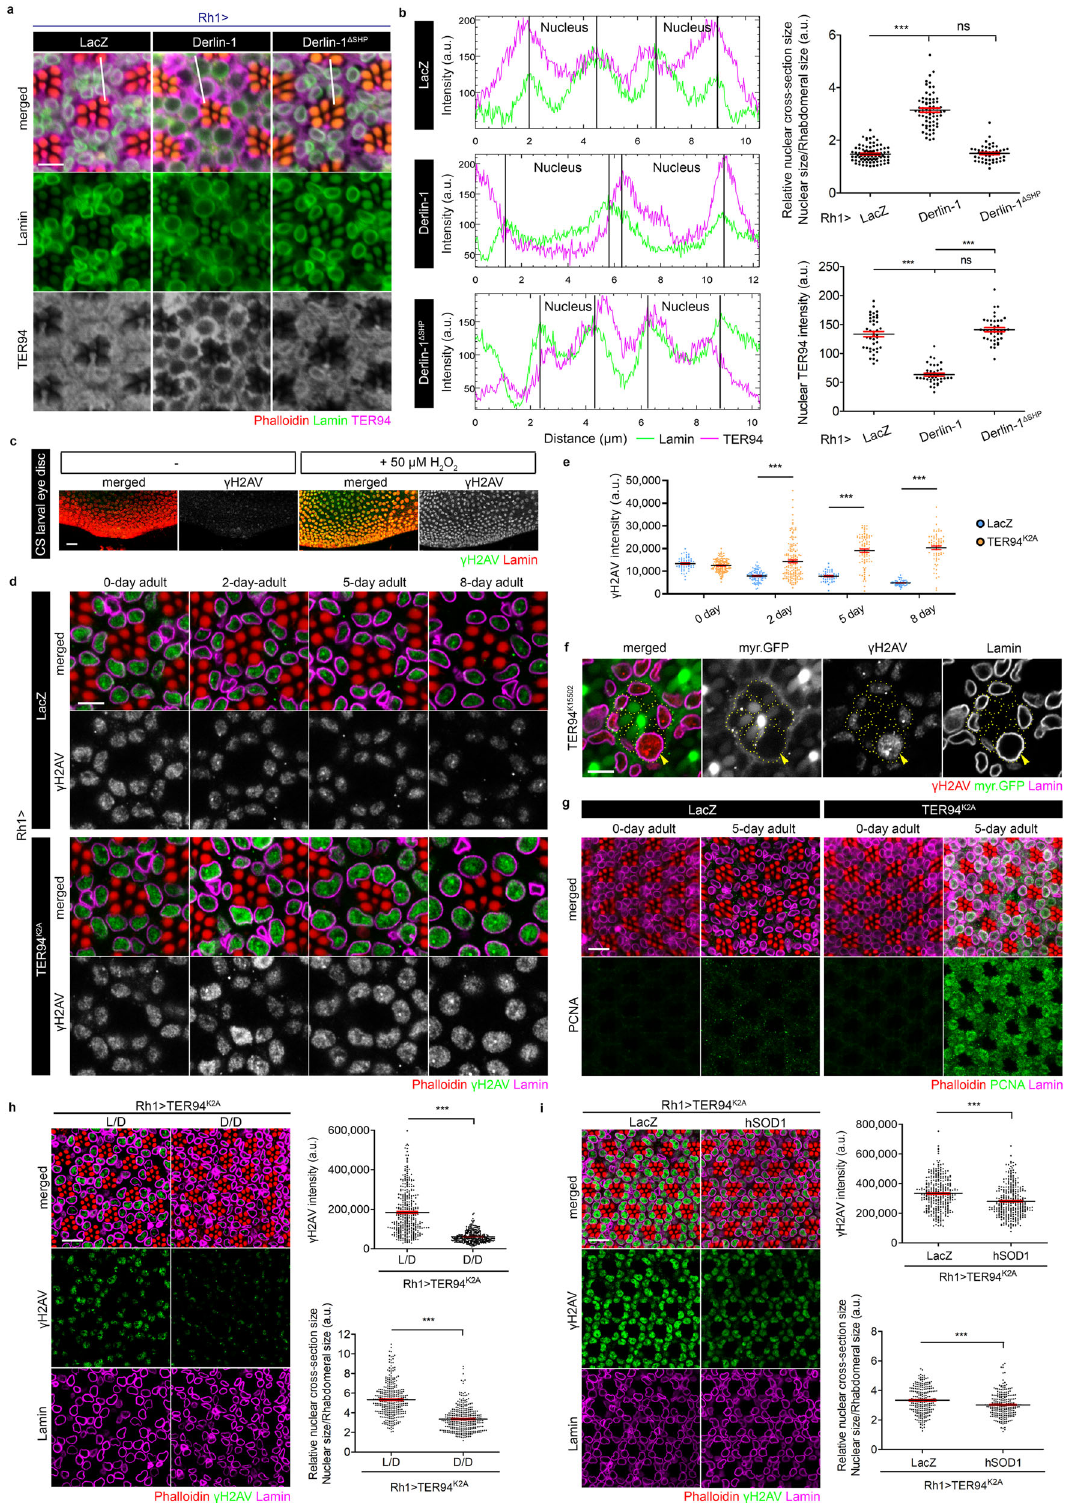
results, indicates that disruption of TER94 function perturbs the DDR process, possibly causing an accumulation of unrepaired DNA